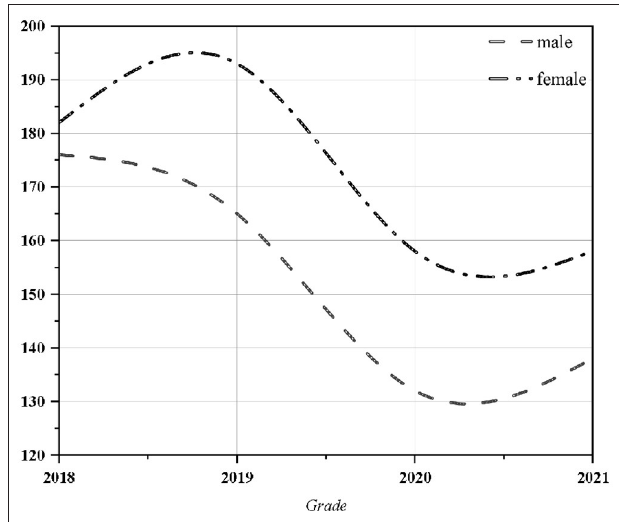
FIGURE 1 | School of design student questionnaire